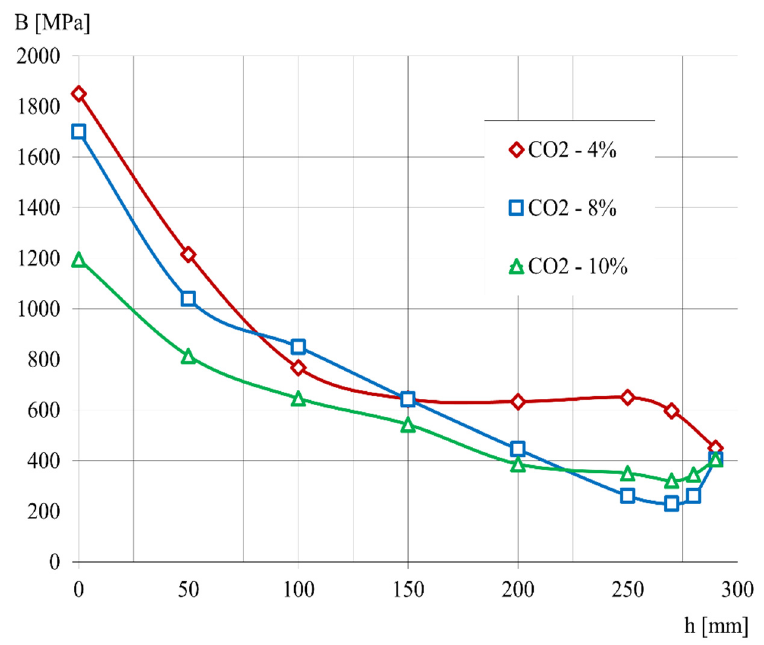
Figure 10. Effect of the amount of exhaust gas dissolved in diesel fuel on the bulk modulus of the solution.